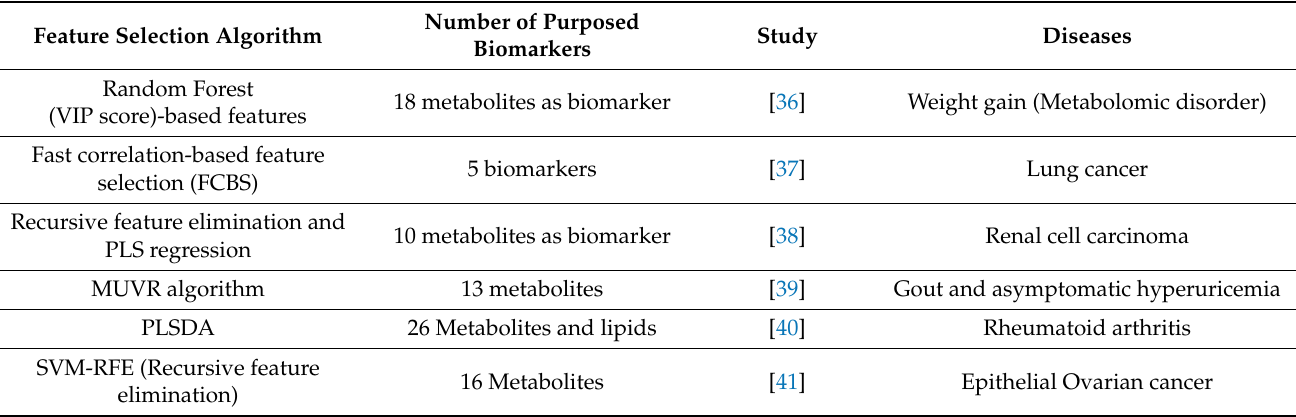
Table 1. Recent studies carried out to discover biomarkers combining metabolomics data and machine learning algorithms. Feature selection algorithms, number of purposed biomarkers, and type of disease are